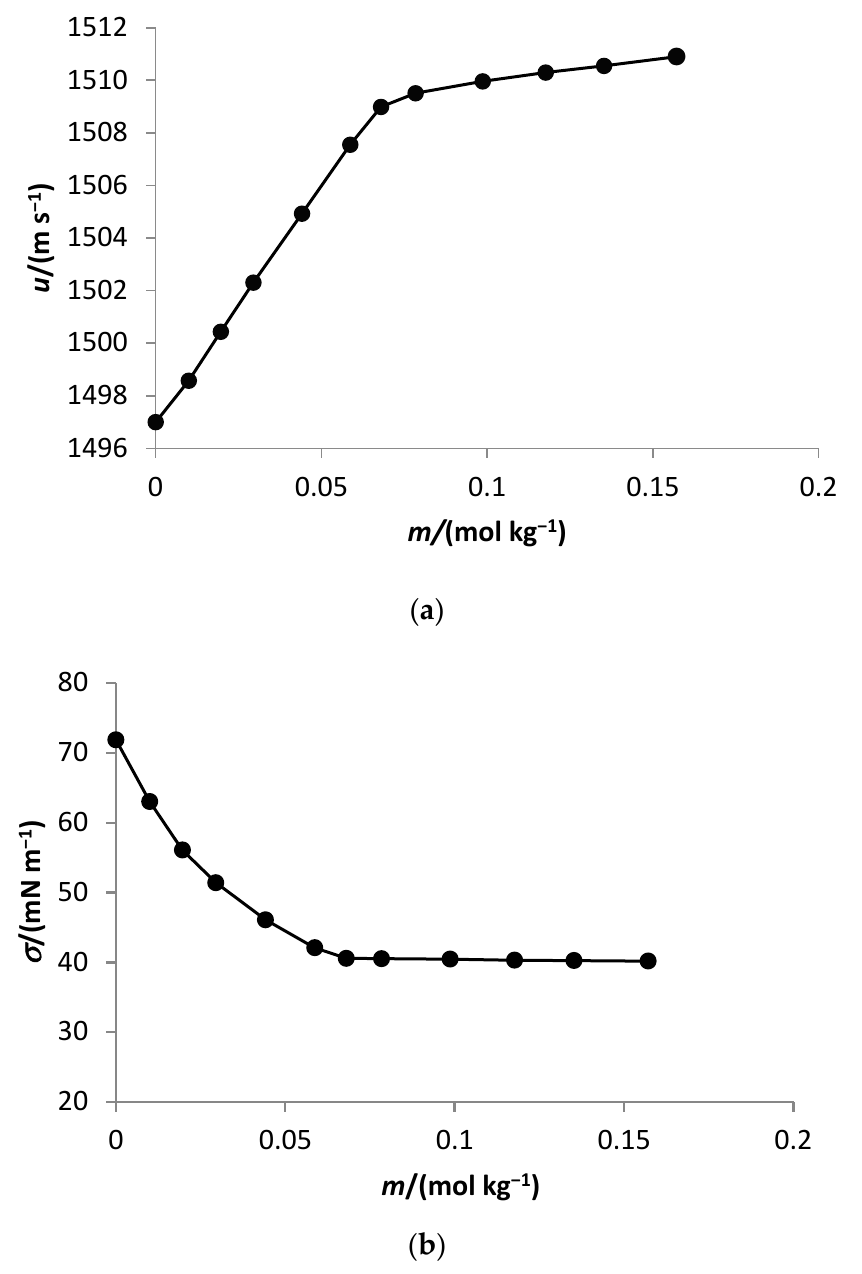
Figure 1. Sound velocity ( a ) and surface tension ( b ) of decyltrimethylammonium bromide in water as a function of molality at 298.15